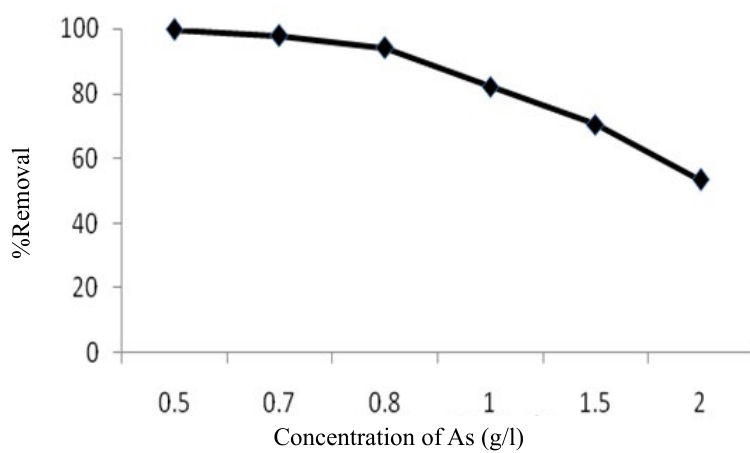
Fig. 3. Effect of initial Arsenic concentration on adsorption.